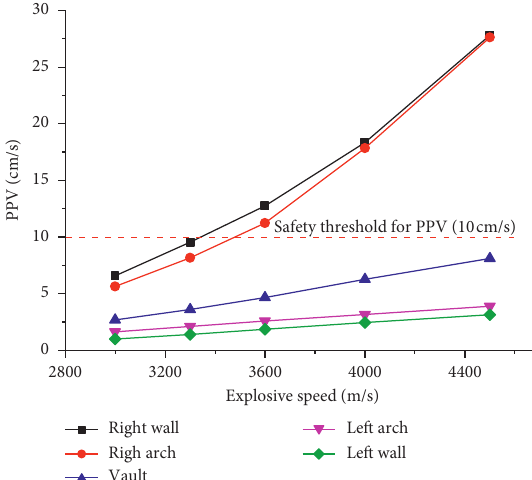
Figure 11: Changes of maximum PPV with Poisson’s ratio.